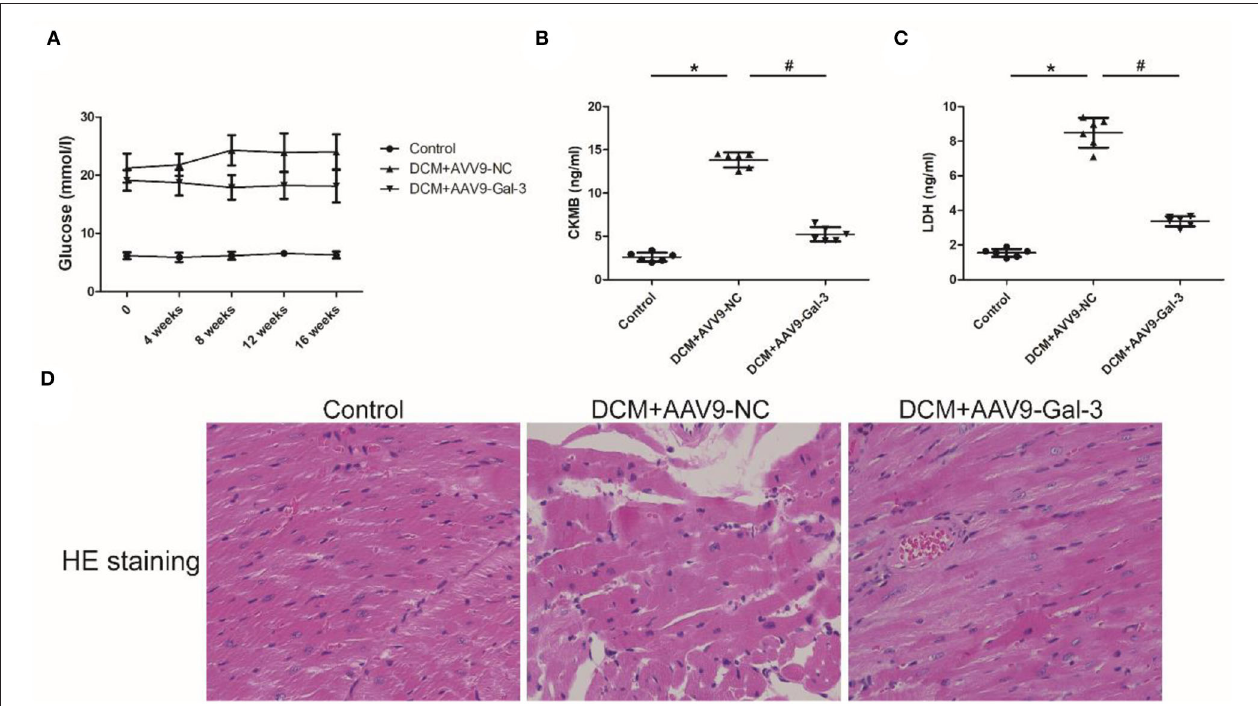
FIGURE 1 | Gal-3 inhibition decreased diabetes-induced cardiac injury (A) blood glucose level was measured during 16 weeks after STZ injection. (B,C) ELISA analysis of heart CK-MB and LDH expression at 16 weeks after STZ injection. (D) HE staining of heart tissue at 16 weeks after STZ injection. Magnification, 200 × . Data are shown as mean ± SD. n = 6, * P < 0.05 vs. Control; # P < 0.0 5 vs. DCM + AAV9-NC.